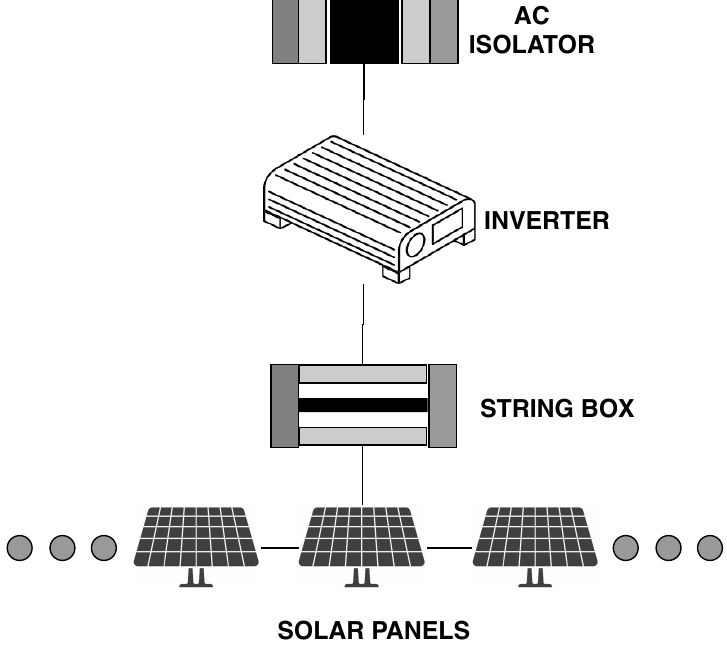
Figure 2. Grid-tie photovoltaic system main